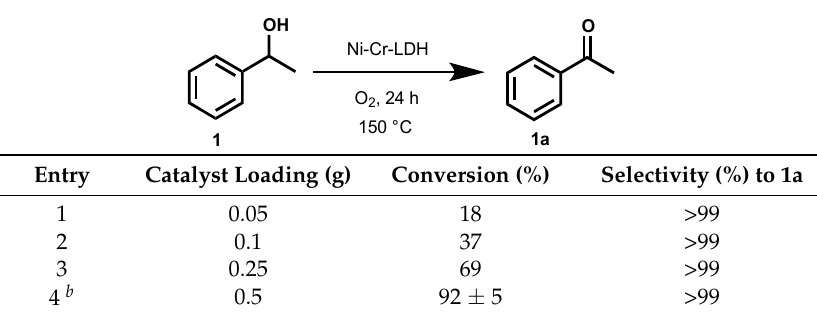
Table 4. Ni ‐ Cr ‐ LDH catalyst loading study a .